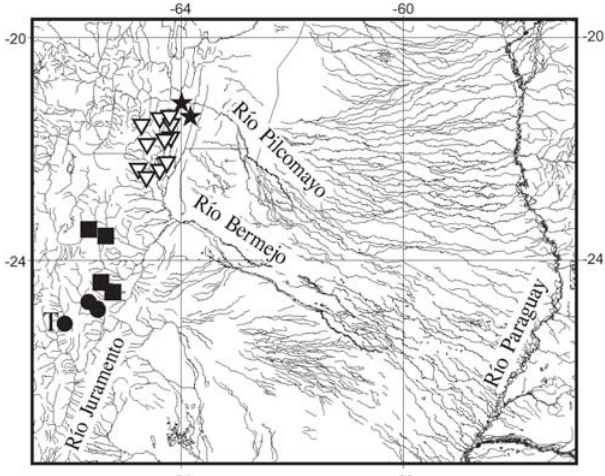
Fig. 9. Distribution of Ixinandria steinbachi . Dot, río Juramento basin; Square, southern upper río Bermejo drain- age; triangle, northern upper río Bermejo basin; and Star, río Pilcomayo. Each symbol can represent more than one lote or locality. (T=Type